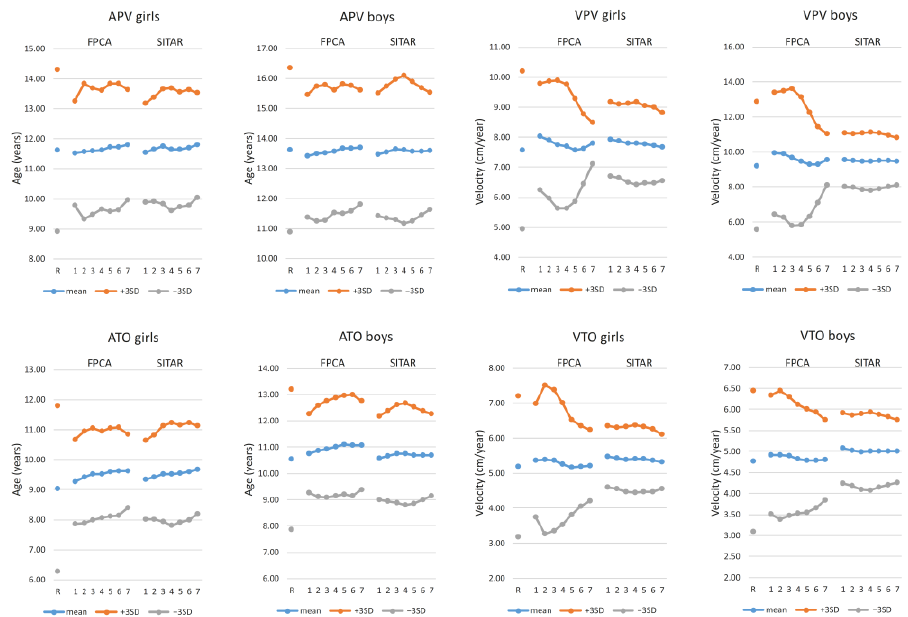
Figure 7. Descriptive statistics for estimates of the growth milestones (APV, VPV, ATO, VTO) for each method (FPCA, SITAR) among girls and boys and by testing sample (1–7) relative to the reference values (R) in the column of each plot.